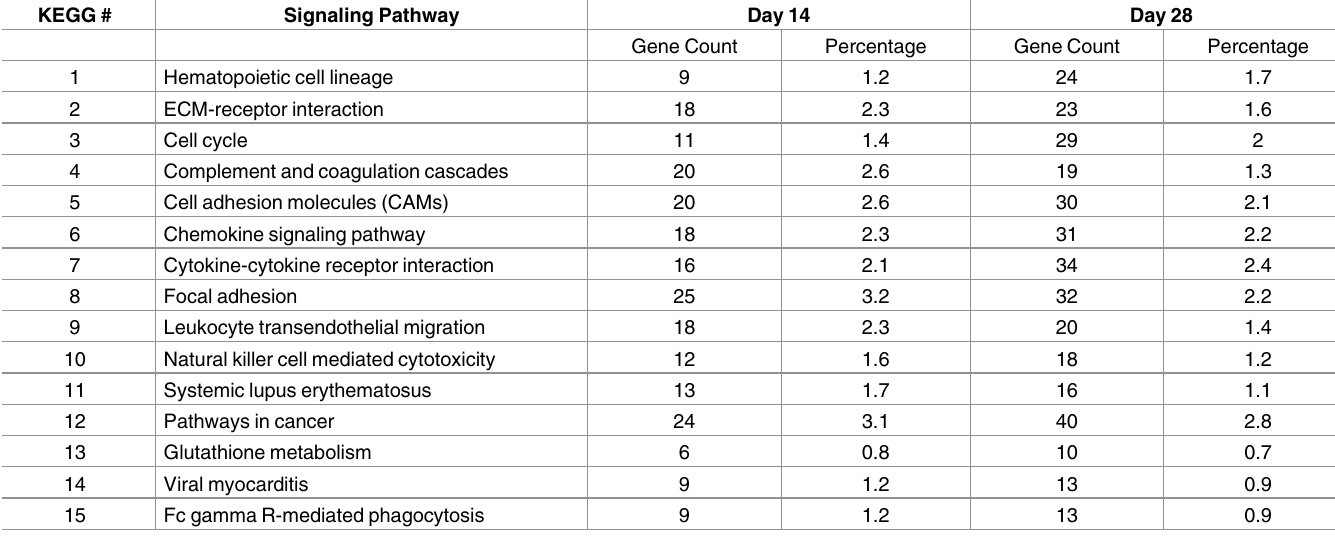
Gene ontology (GO) analysis and pathway analysis of genes also done using DAVID (Database for Annotation, Visualization of Integrated